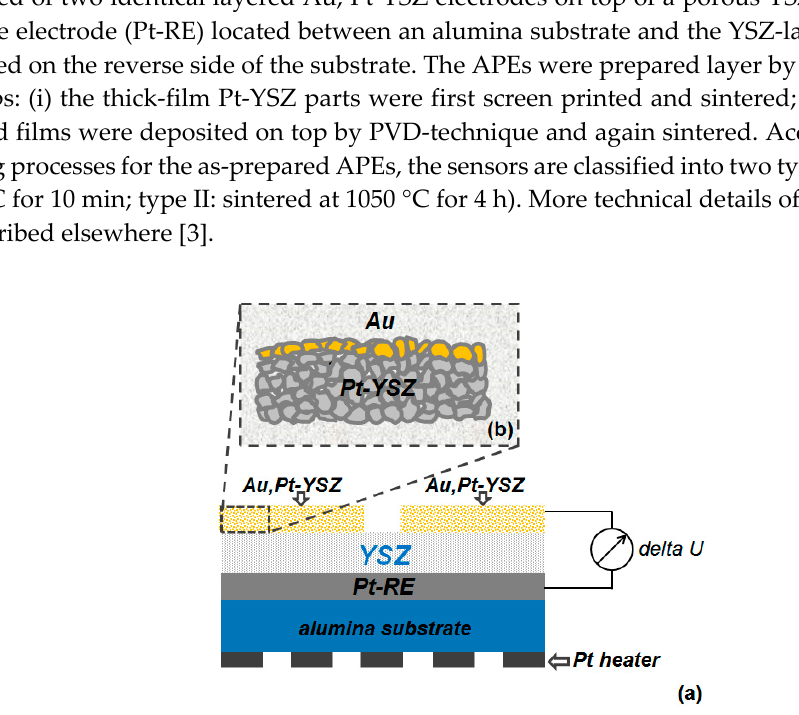
Figure 1. ( a ) Schematic drawing of the CarboSen sensor element (cross-section view); ( b ) the layer structure of the as-prepared Au, Pt-YSZ mixed-potential sensing electrode before